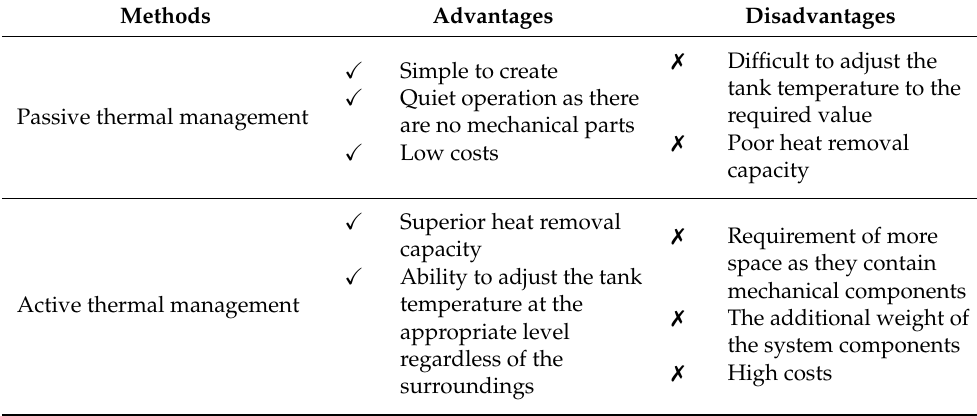
Table 2. The advantages and disadvantages of the thermal management